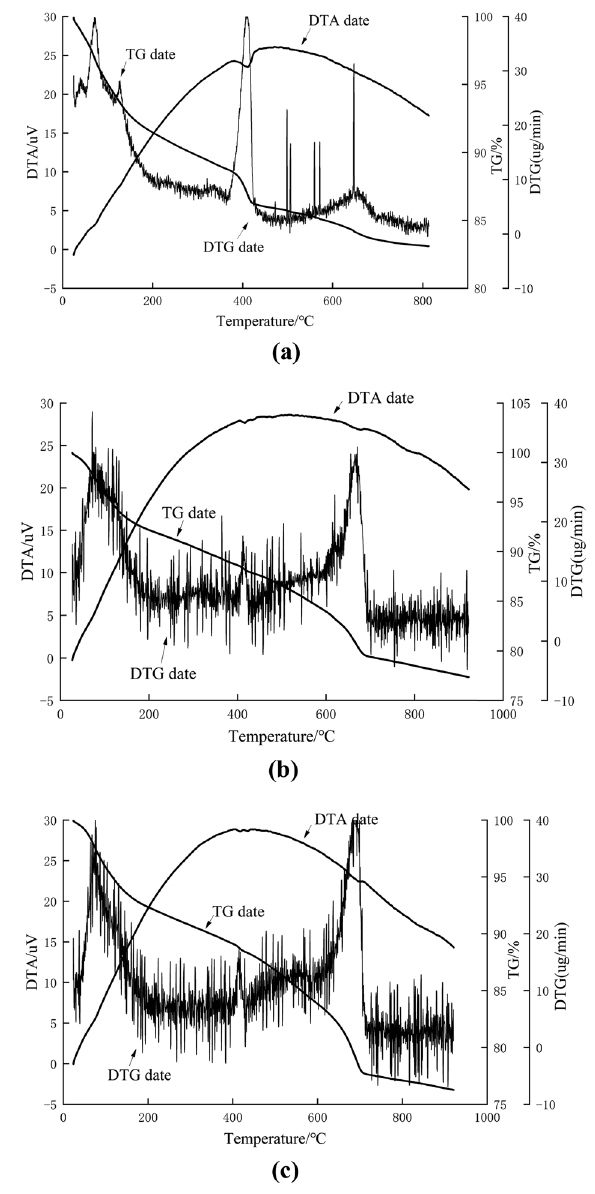
Figure 4: Comprehensive thermal analysisdiagram: ( a ) 0 freeze – thaw cycles; ( b ) 200 freeze – thaw cycles in chlorine solution; and ( c ) 200 freeze – thaw cycles in the sulfate